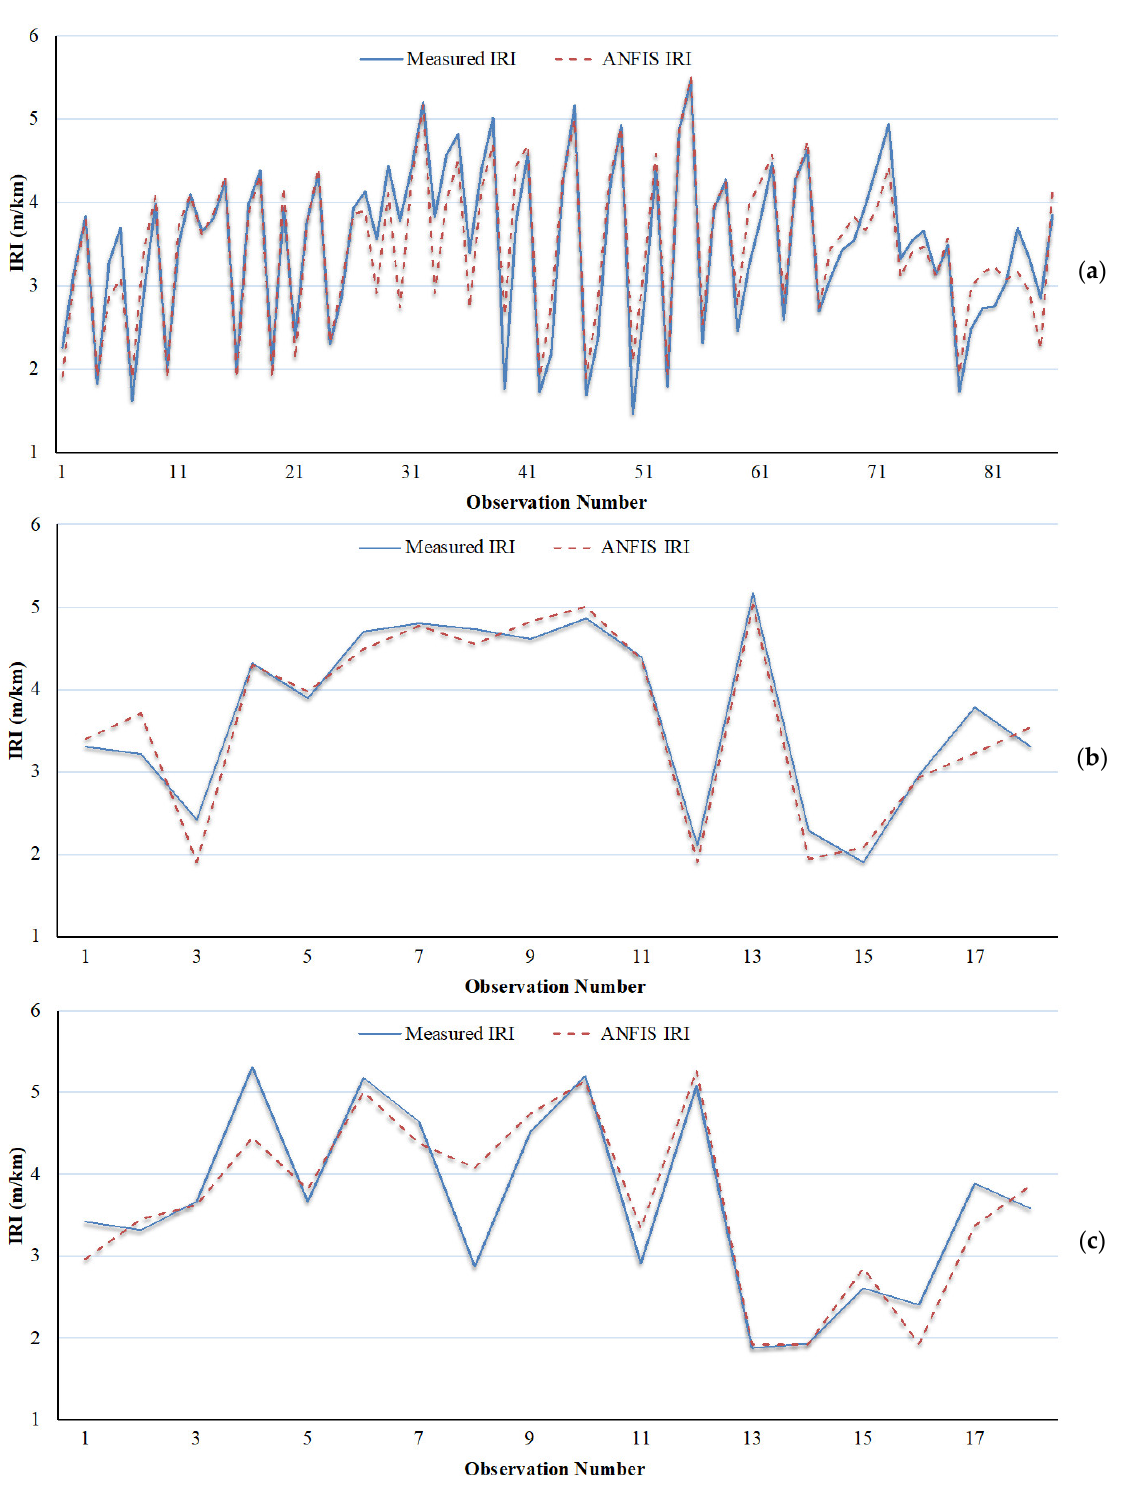
Figure 12. Distribution of the measured and the predicted IRI values of the AC model for the ( a ) training, ( b ) checking, and ( c ) testing data sets. ( a ) training, ( b ) checking, and ( c ) testing data